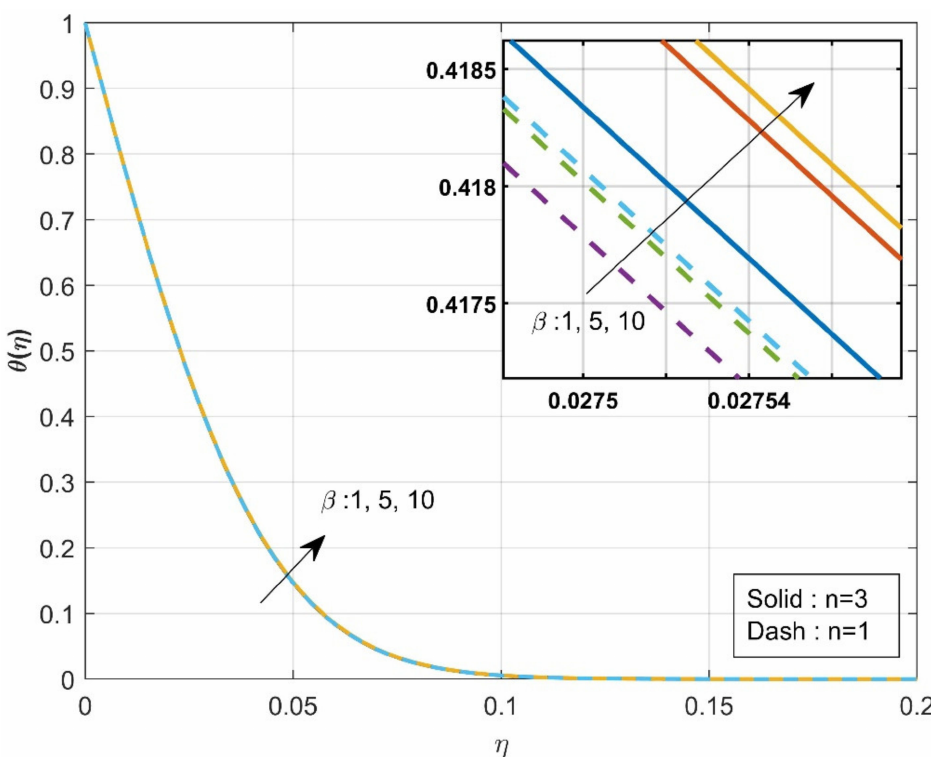
Figure 4. Influence of β over thermal profile θ ( η )